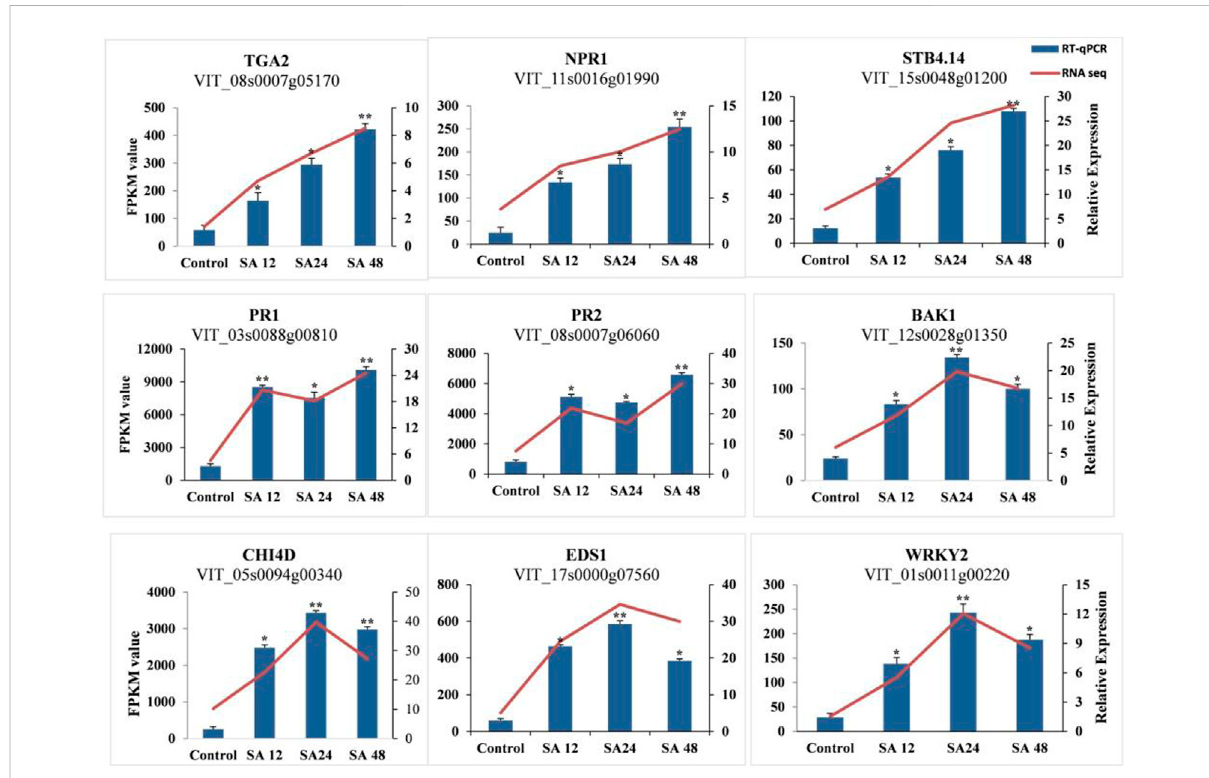
FIGURE 6 Validation of RNA-seq data with RT-qPCR. RT-qPCR of theselected DEGs wasused for the veri fi cation of RNA-seq data. Error bars indicate the standarderrorasmean+SD.Signi fi cantdifferencesbetweenthecontrolandtreatedsamplesareindicatedbyanasterisk(*).Thesign*representsp ≤ 0.05, and ** represents p ≤